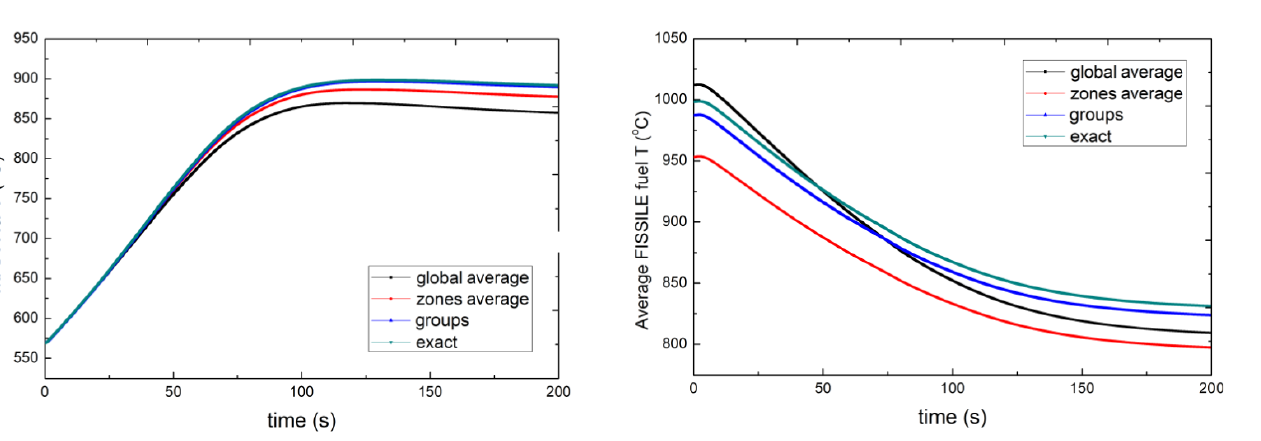
Fig. 8. Sodium maximal temperature during ULOF/PP accident for different thermal properties models.